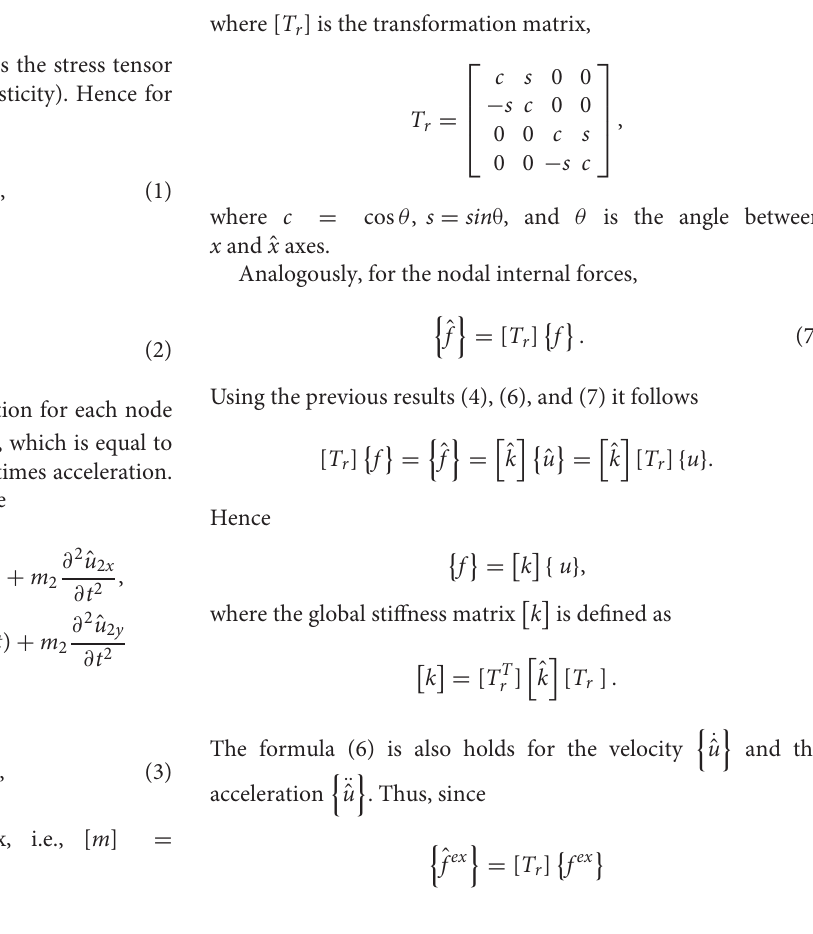
element. According to the classical theory for the